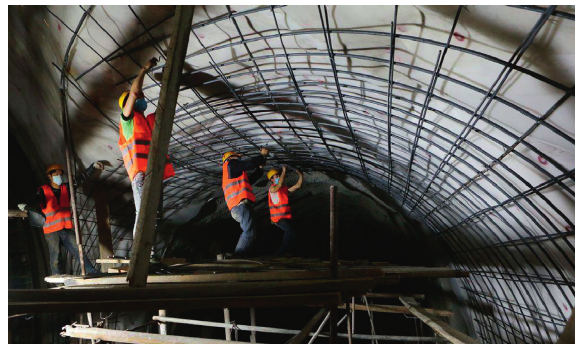
Figure 4: Workers were facing the problem of material shortage in Case 5 (source: http://www.zgjtb.com/2020-02/28/content_236785.